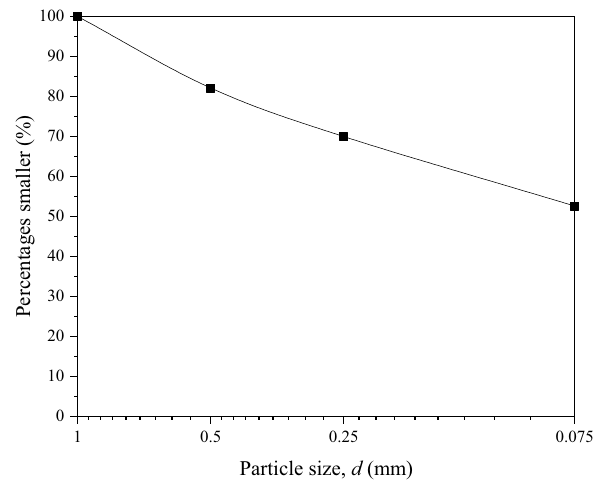
Figure 3. Gradation distributions of soil in the CSCN samples.